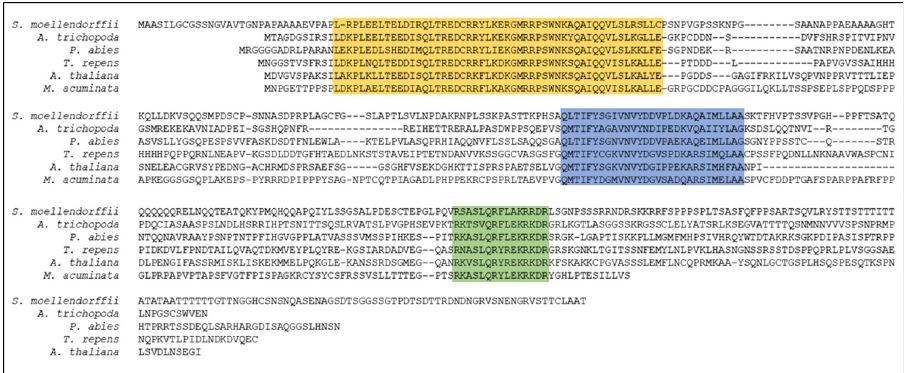
Fig 2. Alignment of representative PPD peptide sequences. PEAPOD proteins contain three regions that are highly conserved; these are indicated by the yellow background (PPD domain), blue background (TIFY domain) and green background (truncated Jas domain). Sequences include: A . thaliana (accession NP_567442.2), S . moellendorffii (accession XP_002964672), A . trichopoda (accession XP_006838952.1), P . abies (accession MA_99597G0010, congenie.org), T . repens (accession MZ736871) and M . acuminata (accession M0S6C8_MUSAM,